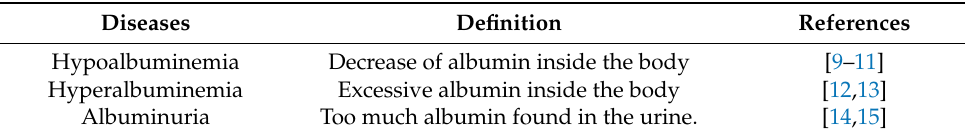
Table 1. Diseases associated with